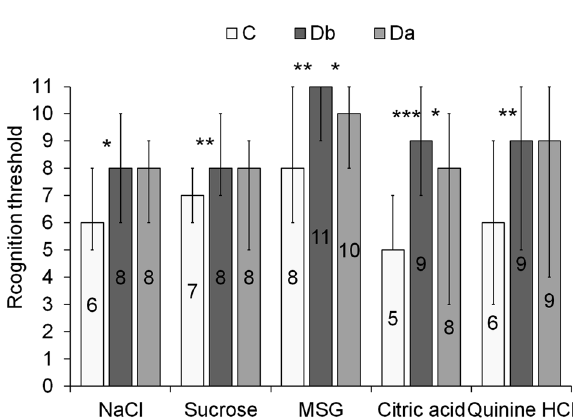
Fig. 2 Recognition threshold (the sample with lowest concentra- tion resulting in the correct recognition of a taste category) for salty (NaCl), sweet (sucrose), umami (monosodium glutamate or MSG), sour (citric acid), and bitter (quinine hydrochloride or HCl) solutions in Control Group (C), in people with diabetic mellitus before (Db) and after (Da) hyperbaric oxygen therapy. Number 11 — no sensation; box — median, whisker — interquartile range; * p < 0.05, ** p < 0.01, ** p <